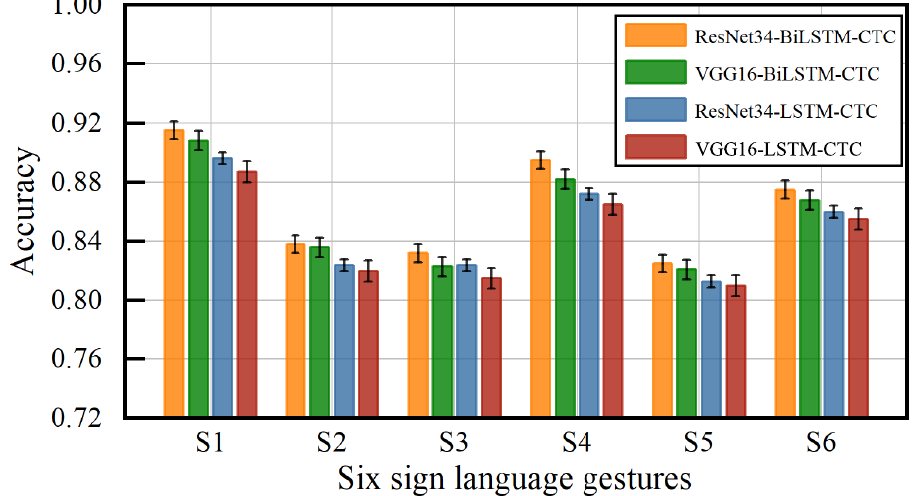
Figure 16. Impact of different models on accuracy of sign language